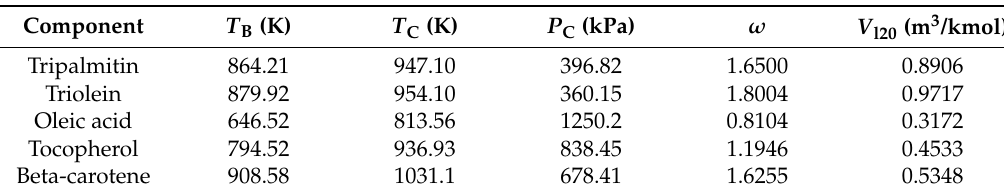
Table A1. Physical properties of pure components in palm oil, reproduced with permission from [13]. Copyright Springer, 2003.